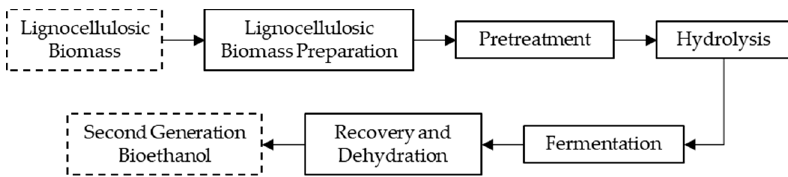
Figure 1. Steps for the conversion of lignocellulosic biomass (LCB) into bioethanol.